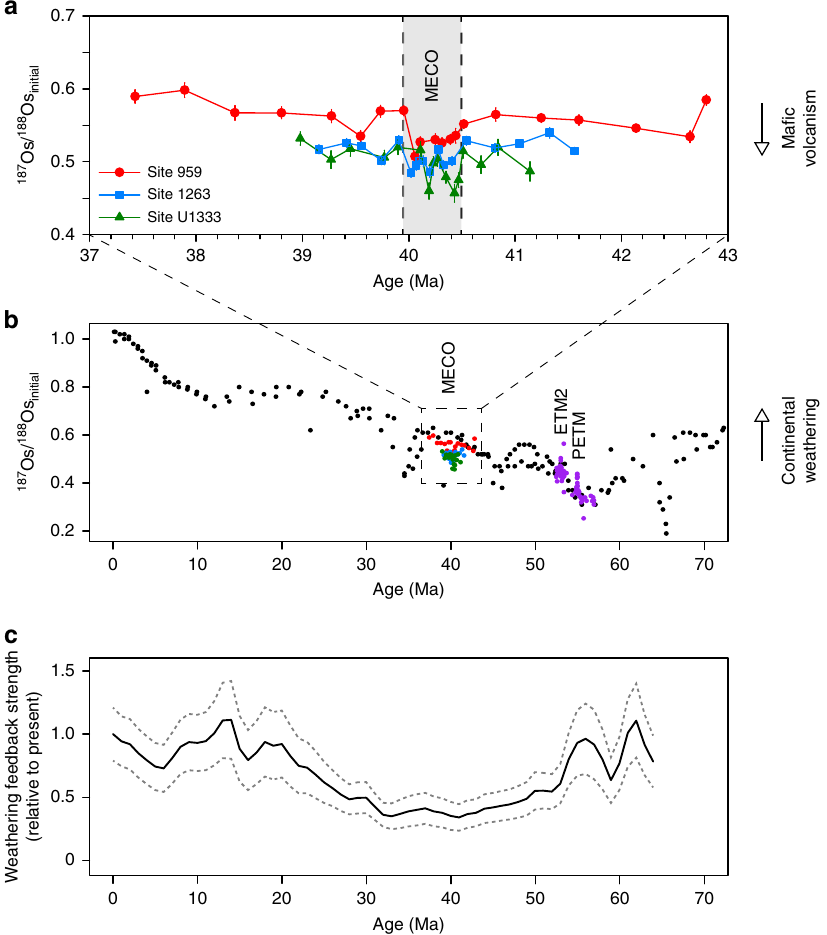
Fig. 2 Comparison of Os i records from the MECO with Os i records from the PETM and ETM2, shown against the overall Os i evolution of the Cenozoic and the relative weathering feedback strength of the Cenozoic. a MECO data from Site 959 (in red), Site 1263 (in blue) and Site U1333 (in green) plotted against age (GTS2012) 74 . See Methods for discussion of the age models for the study sites. b MECO data from Sites 959, 1263, and U1333 (this study); PETM and ETM2 data from DSDP Site 549 (in purple) as published in Peucker-Ehrenbrink & Ravizza 15 ; Cenozoic data from ferromanganese crusts D11 and CD29 (in black) as published in Klemm et al. 27 and Burton 28 , respectively, based on the updated age model of Nielsen et al. 29 . c Model estimates of the relative continental weathering feedback strength of the Cenozoic as published in Caves et al. 57 , based on their CO 2 scenario 1 and a logarithmic